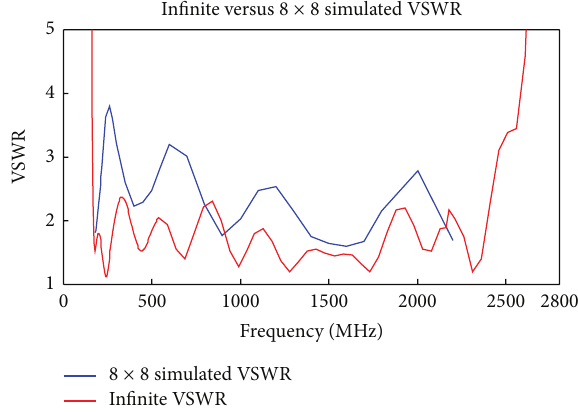
Figure 12: VSWR comparison of the infinite versus 8 × 8 finite TCDA-IBarraydefinedinFigures5–9.Itisnotedthatthetruncation effects of the edge elements of the 8 × 8 array are responsible for the higher VSWR associated with the 8 × 8